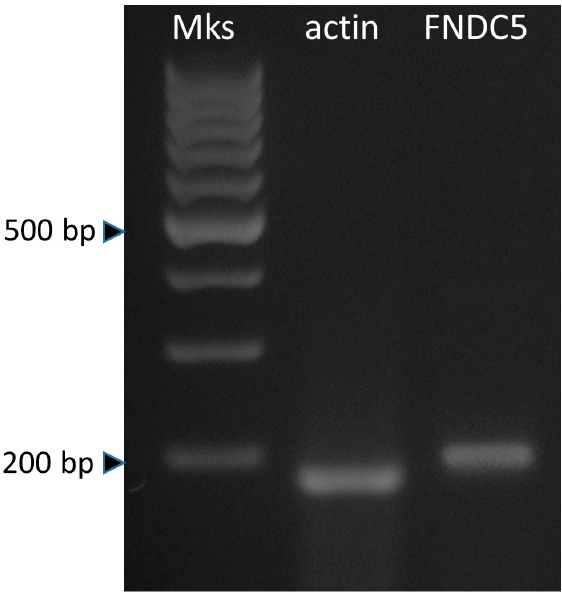
Figure 1. FNDC5 and actin expression in swine adipose stromal cells. The cellular metabolic activity, assessed by the production of ATP, was significantly stimulated ( p < 0.05) by the presence of Irisin at a concentration of 150 ng/mL. A quantita- tive colorimetric assay based on the ability of bromodeoxyuridine (BrdU) to incorporate into DNA during the S phase was used to study the changes in cell proliferative activity. Irisin treatment induced a reduction in cell proliferation ( p < 0.001) (Figure 2A,B).